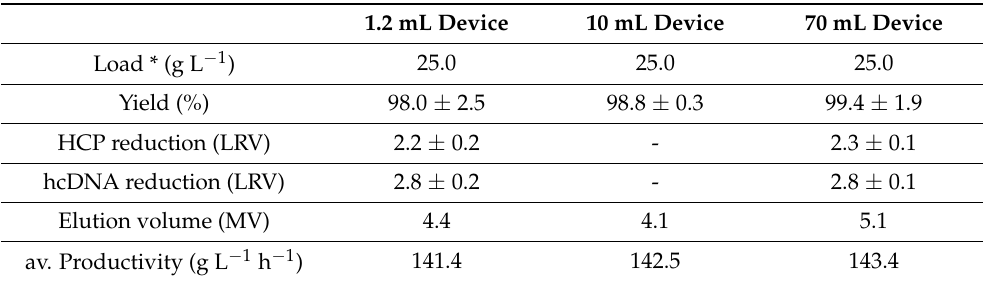
Table 5. Overview of process-related parameters and product quality attributes.